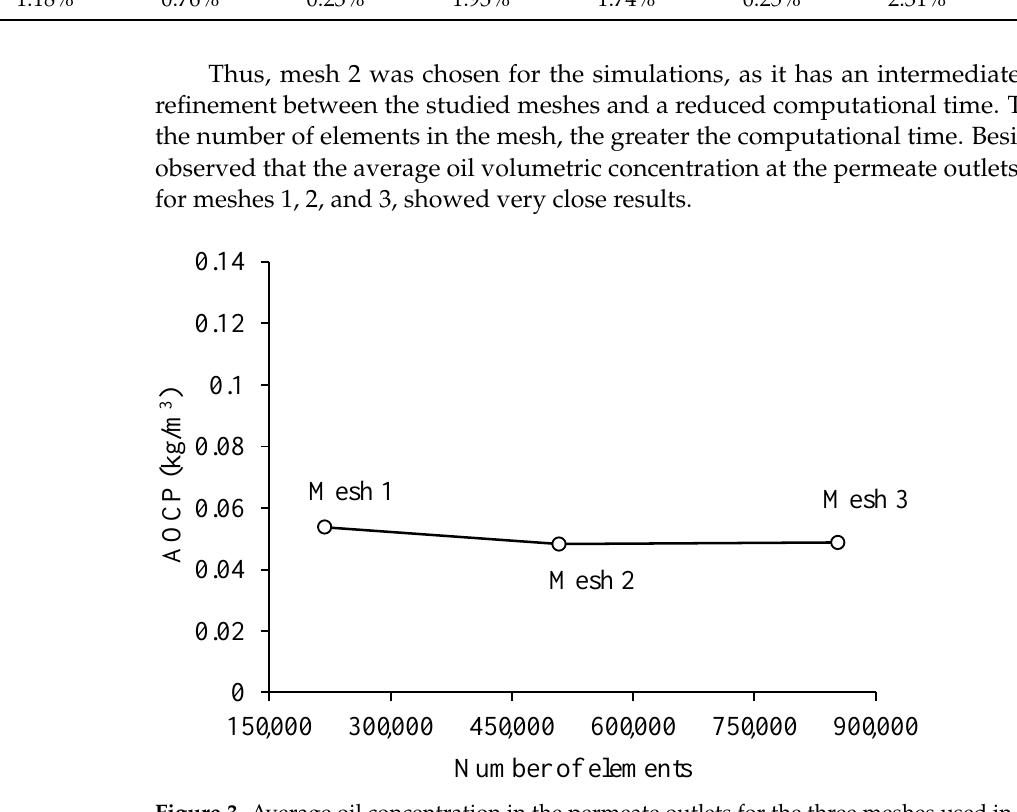
Figure 4. Transverse planes, in the hull region, chosen for data analysis.